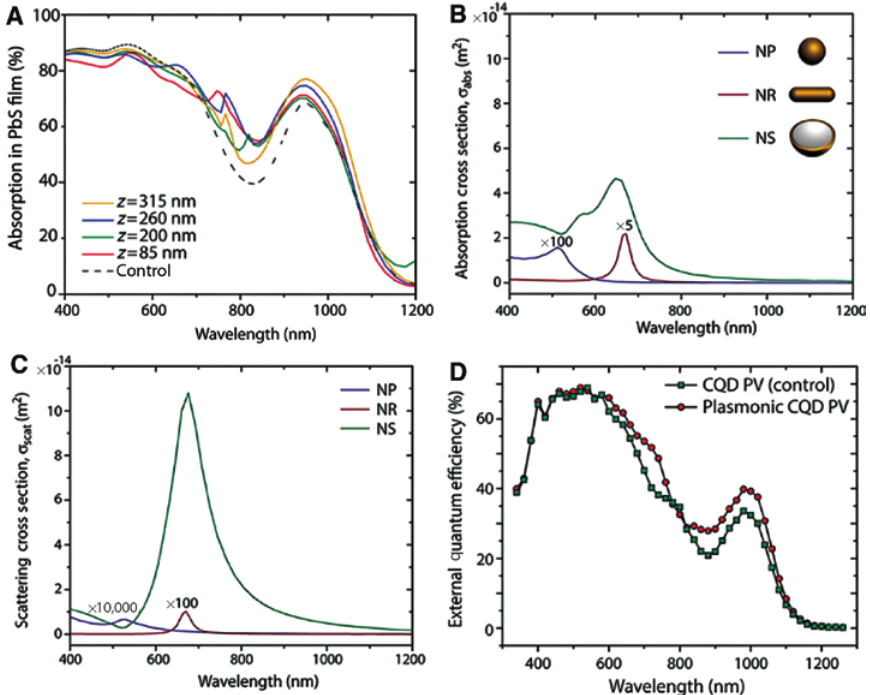
Figure 21: 3D FDTD simulation of plasmonic-excitonic films. (A) Absorption spectra (including back-reflector) in a 400-nm-thick PbS quantum dot film with nanoshells embedded at different values of z , the distance from the PbS bottom-illuminated interface to the center of the nanoshells. The nanoshells are periodically spaced by an average of 300 nm, (B) absorption and (C) scattering cross-section spectra as a function of shape, (D) external quantum efficiency spectra of control and plasmonic CQD solar cells. A peak 35% enhancement centered at a wavelength of 880 nm was observed in the plasmonic device. Reprinted with permission from [111]. Copyright 2013 American Chemical